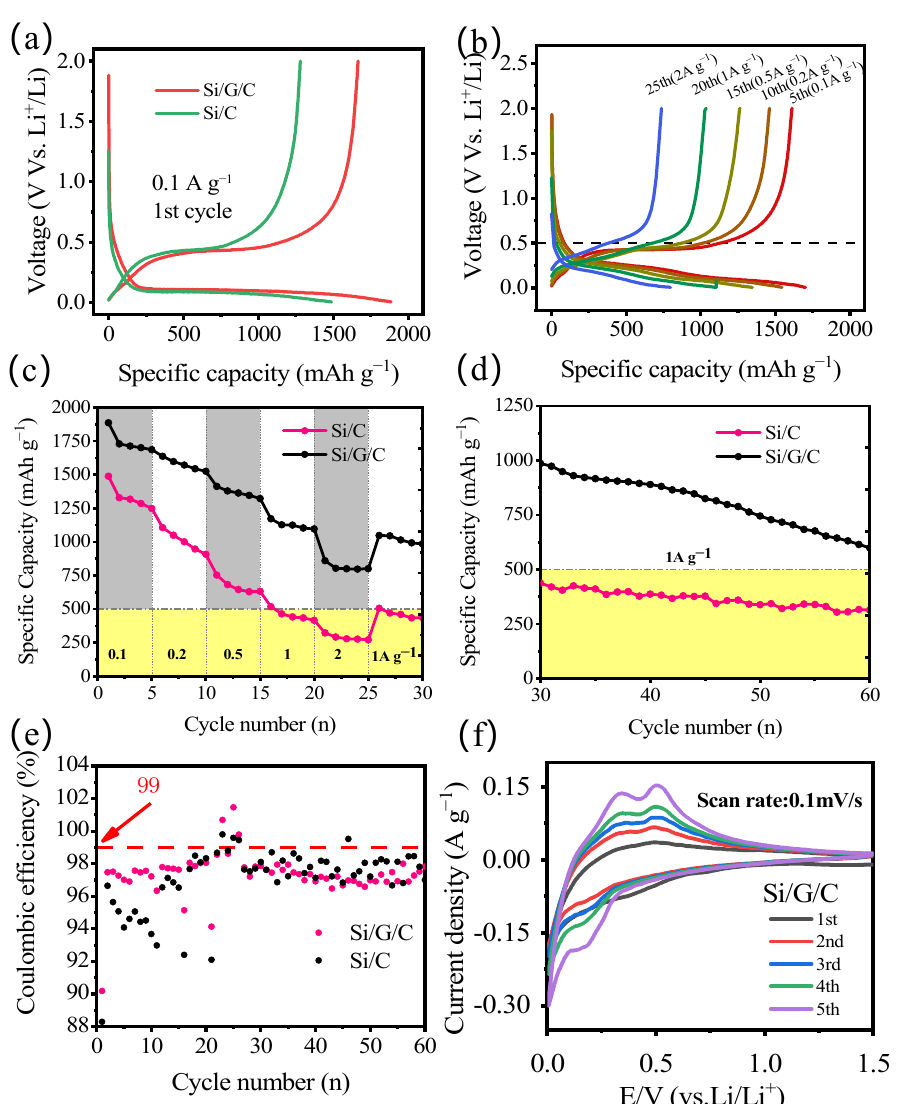
Figure 5. ( a ) The initial charge and discharge profiles of Si/G/C and Si/C anodes at 0.1 A g − 1 . ( b ) Charge/discharge profiles of the Si/G/C anode under various current densities. ( c ) Rate capabilities of Si/G/C and Si/C anodes measured under various current densities from 0.1 A g − 1 to 2 A g − 1 . ( d ) The cycling performance of the Si/G/C and Si/C anodes at a current density of 1 A g − 1 . ( e ) The coulombic efficiency of Si/G/C. ( f ) Cycle voltammetry of the Si/G/C composite at different cycles in the potential range from 0.01 to 1.5 V (vs. Li/Li +